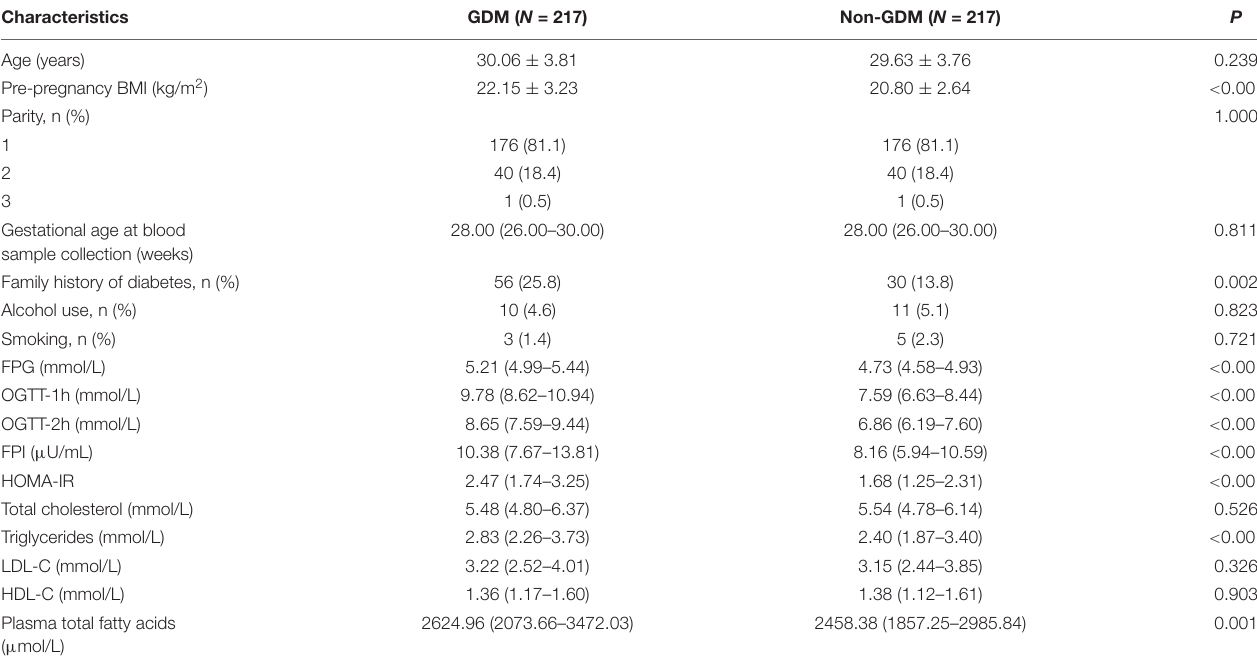
TABLE 1 | Characteristics among women with GDM and their matched controls.